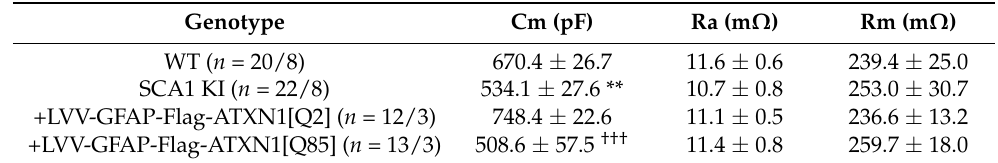
Table 1. Passive electrophysiological properties of PCs from 12-week-old mice. Cm—membrane resistance, Ra—access resistance, Rm—membrane resistance. t -test indicates significant effects in Cm. n —number of cells/number of animals, ** p < 0.001; ††† p < 0.001.